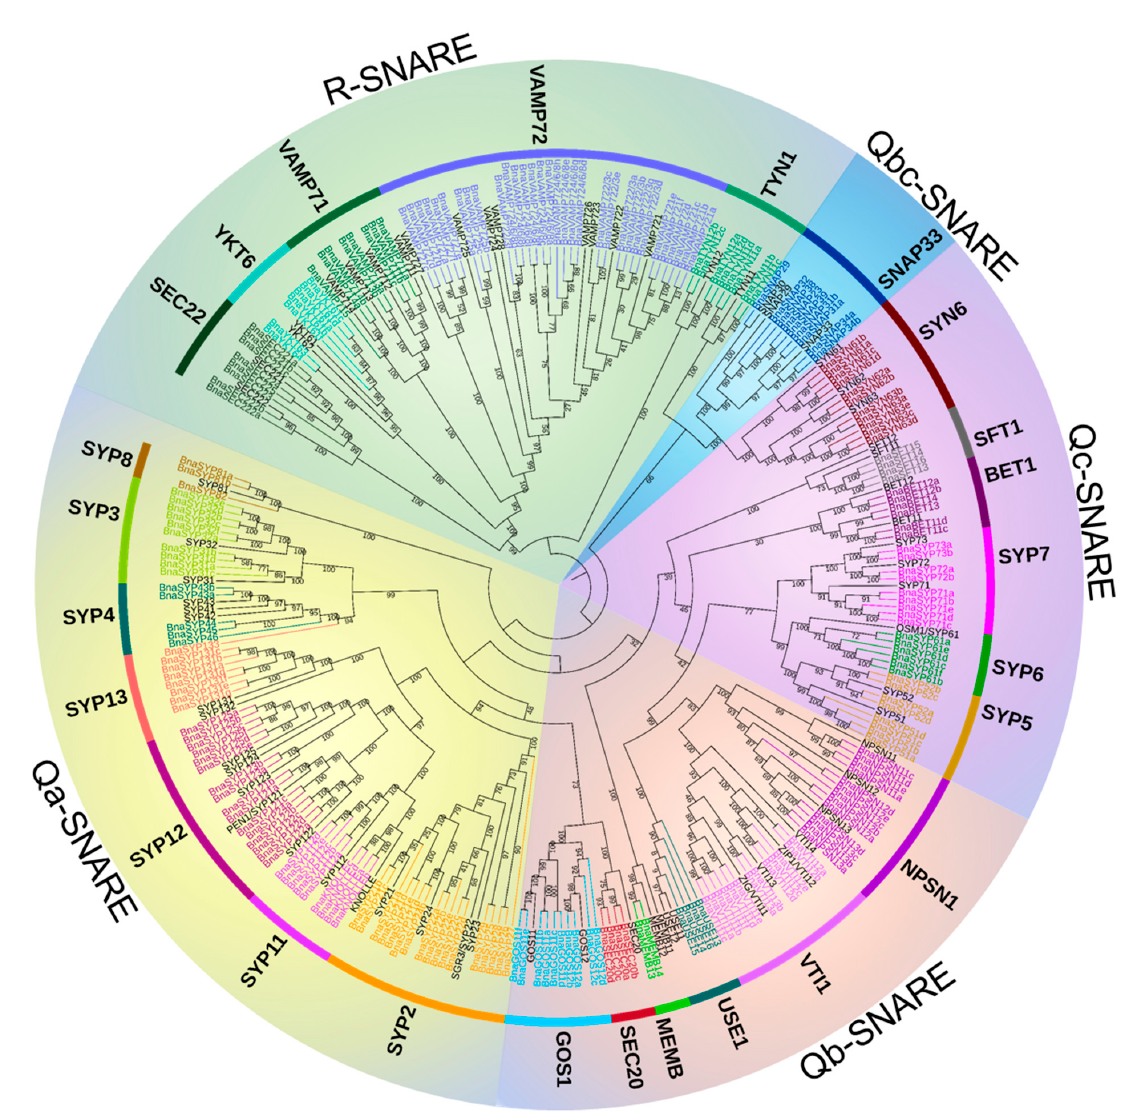
Figure 1. Maximum-likelihood phylogeny of SNARE proteins from B. napus and A. thaliana . A phylogenetic tree of SNARE proteins from B. napus and A . thaliana was constructed using IQ-TREE. The colored B. napus genes are subclade-specific, whereas A. thaliana genes were in black. Subfamilies were indicated using A. thaliana gene names, and sub-family names according to priority rule [11] were shown in brackets if different from the A. thaliana gene names. Despite the absence in other research, the A. thaliana genes SYN61 , SYN62 , and SYN63 and their orthologous in B. napus were included in the phylogeny. A version of the tree with untransformed branches and including the accession numbers can be found in Figure S2.